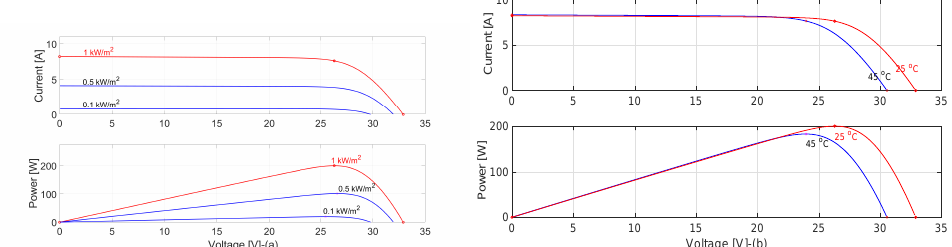
Figure 12. The I-V and P-V characteristics of KC200GT PV module at different atmospheric conditions (Matlab/Simulink PV emulator): ( a ) Solar radiation ( b ) Temperature.